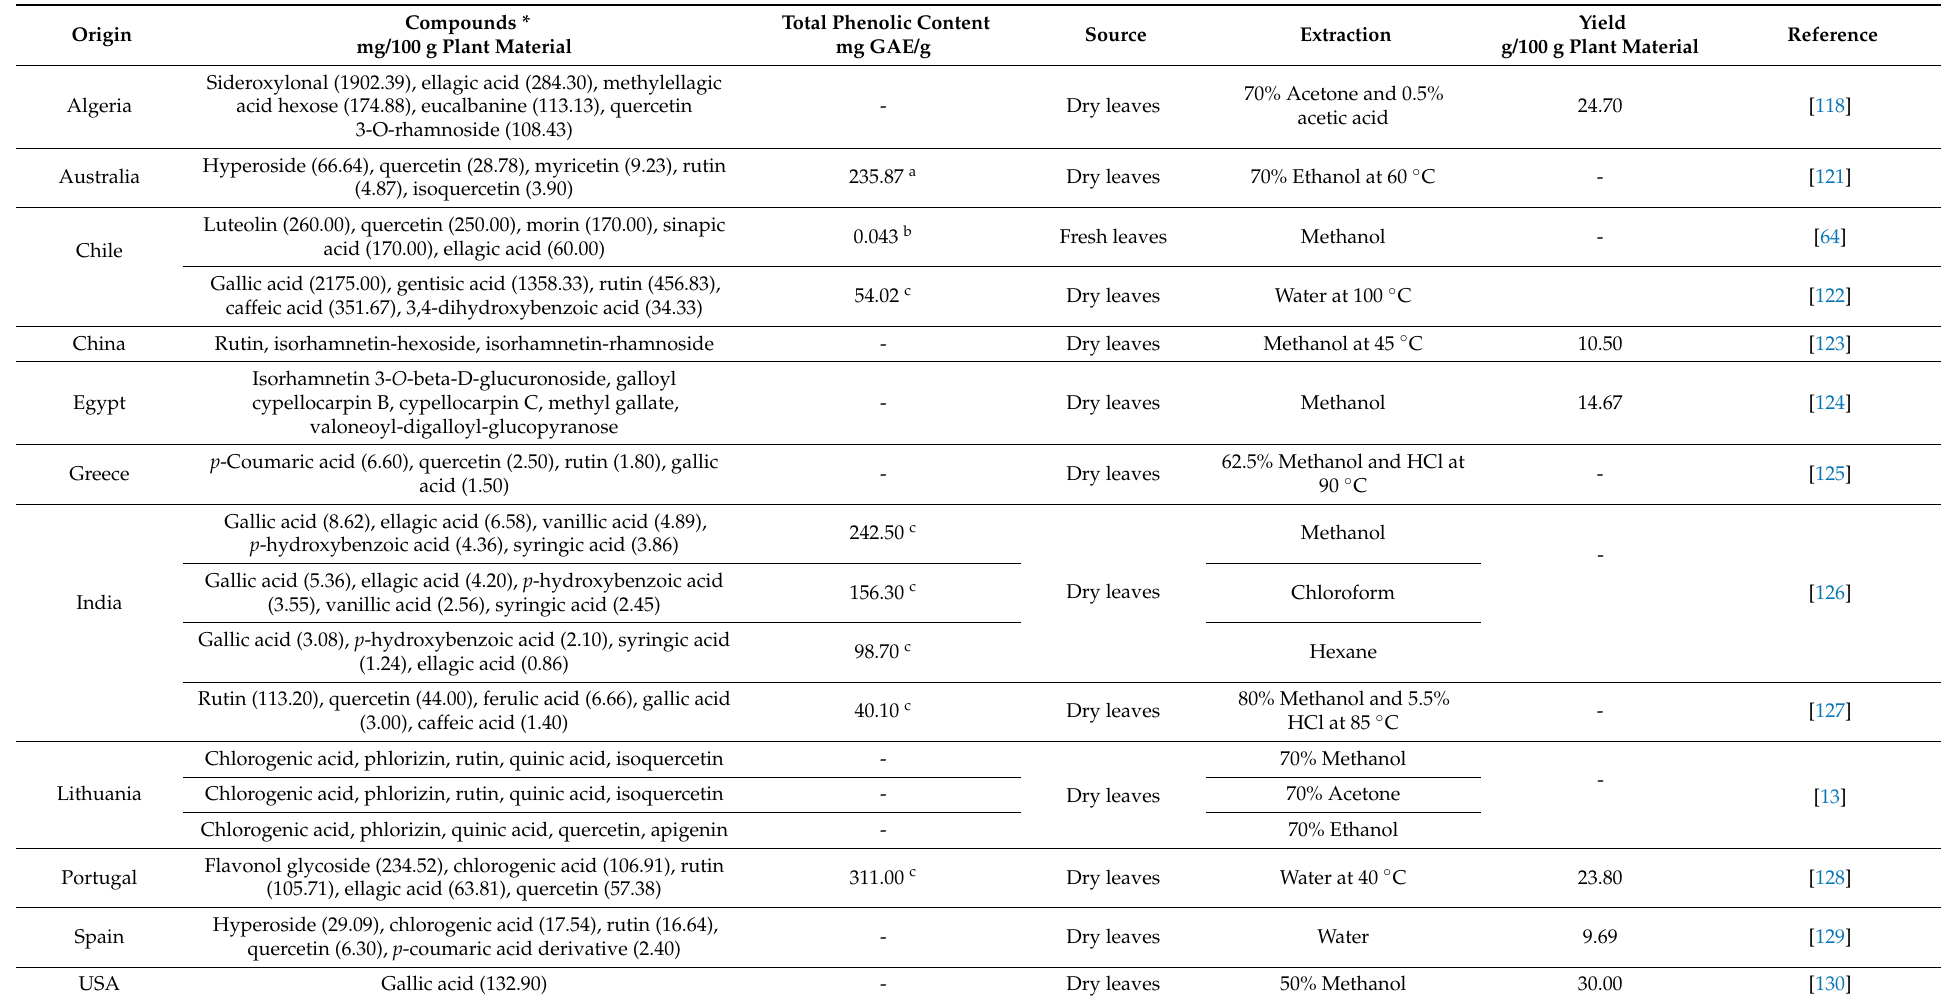
Table 2. Phenolic compounds from Eucalyptus globulus leaves